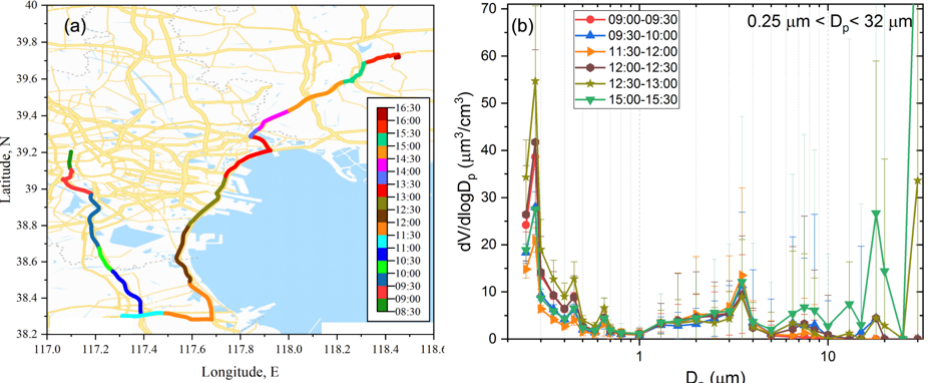
Figure 4. ( a ) GPS track of the mobile measurements from Tianjin to Tangshan, color-coded by 30 min time intervals (local time, UTC +8 h) and ( b ) particle volume size distributions measured by Grimm Sky-OPC, averaged on 30 min transect segments.